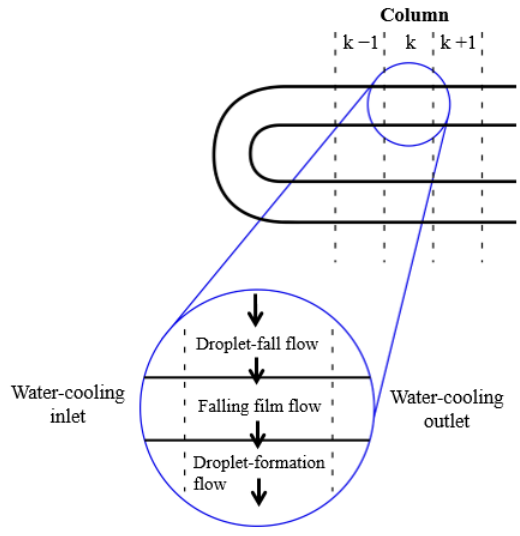
Figure 5. k ‐ th element of the physical model [8]. Figure 5. k-th element of the physical model